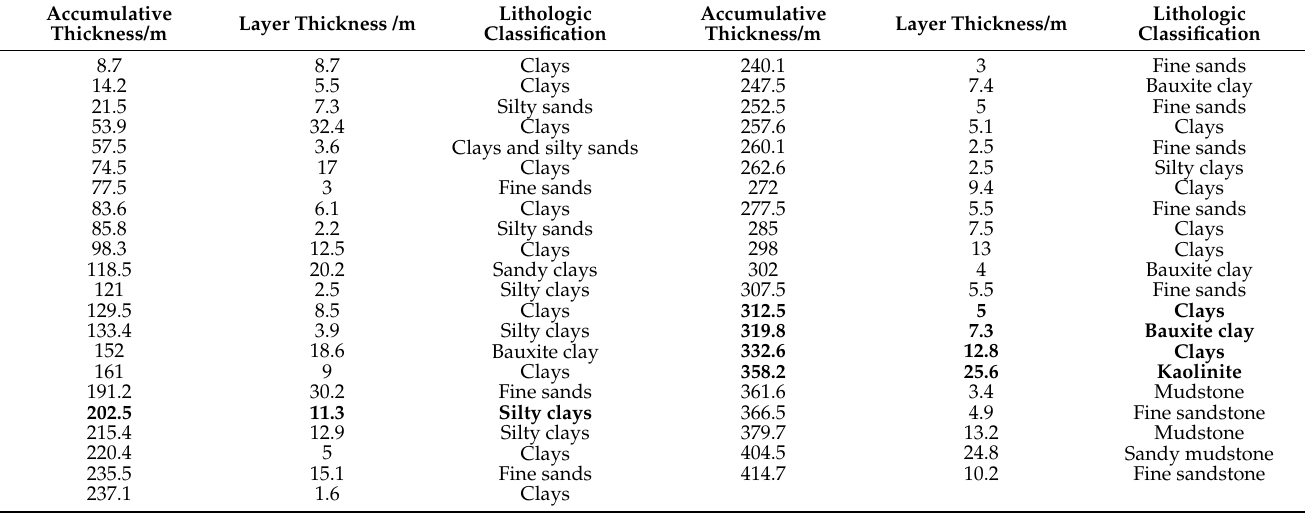
Table 1. The layer conditions in the topsoil around the east ventilation